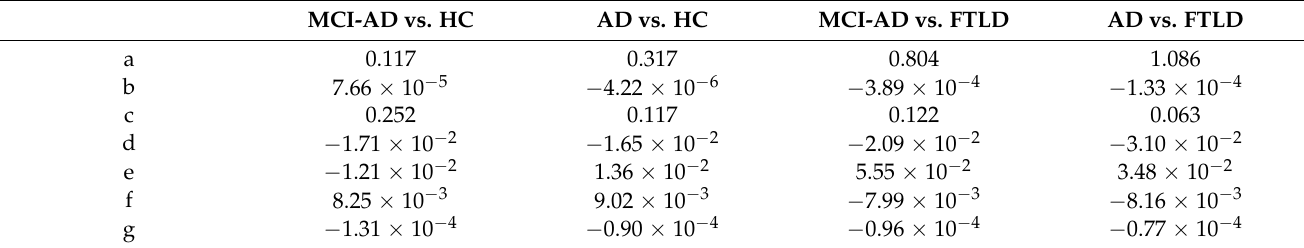
Table 6. Corrected coefficients for the models’ equations.